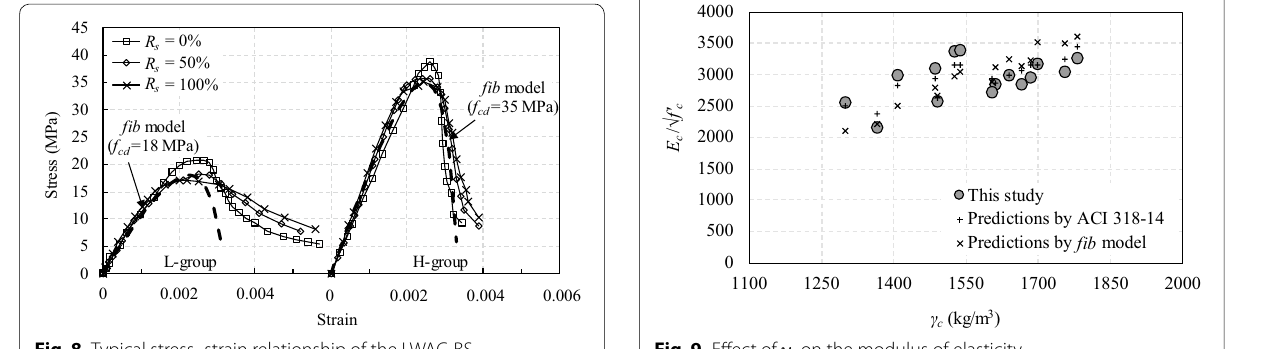
Fig. 8 Typical stress–strain relationship of the LWAC‑BS. Fig. 9 Effect of γ c on the modulus of